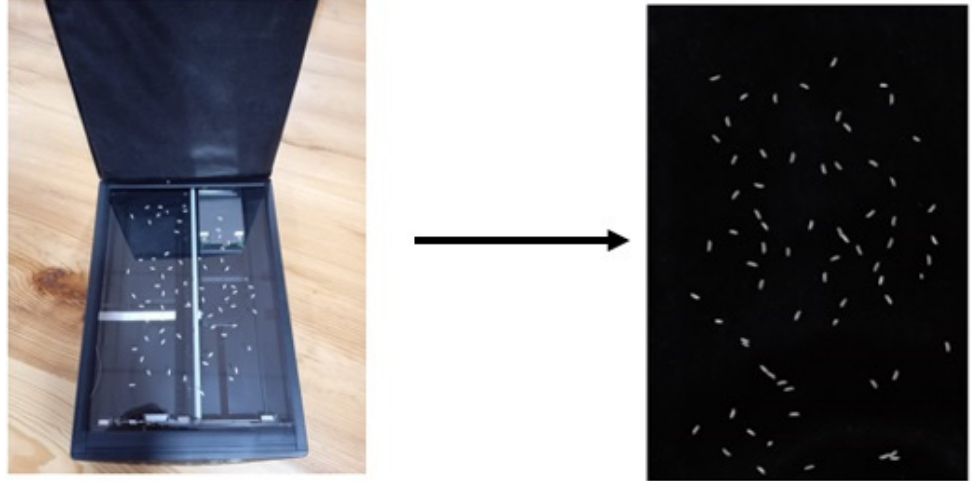
Figure 4. Image of the rice sample acquired from a calibrated flatbed scanner.